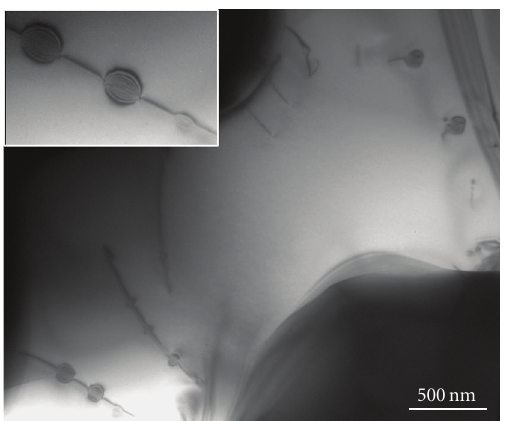
Figure 4: BF-TEM micrograph of an MoSi 2 grains where necklaces of dilocations are visible (enlarged view in the